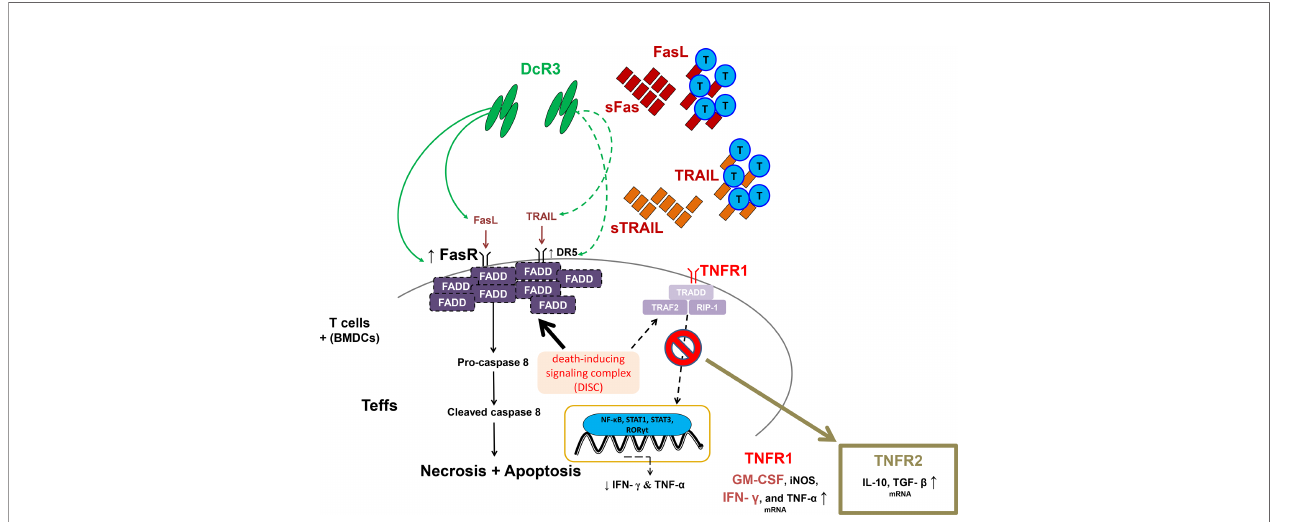
FIGURE 8 | A simple schematic diagram illustrating the potential effects of decoy receptor 3 on T-cells in the acute T-cell-mediated rejection. FADD, Fas-associated protein with death domain; GM-CSF, granulocyte – macrophage colony-stimulating factor; iNOS, inducible nitric oxide synthase; RIP1, receptor-interacting serine/ threonine kinase 1; ROR g t, retineic-acid-receptor-related orphan nuclear receptor gamma; STAT1, signal transducer and activator of transcription 1; STAT3, signal transducer and activator of transcription 3; TGF- b , transforming growth factor beta; TRADD, TNFR1-associated death domain protein; TRAF2, TNF receptor- associated factor